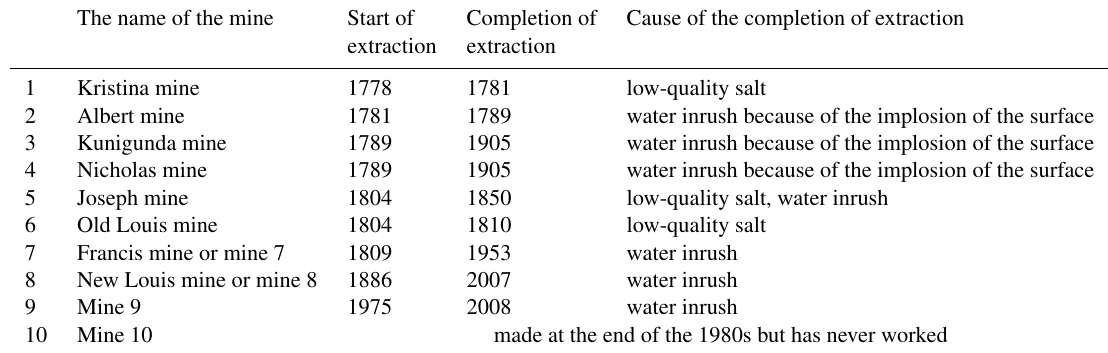
Figure 3. The investigated area. (a) Overview map of Solotvyno and its surroundings, showing the approximate location of the salt dome. Lakes with hatch pattern show sinkholes opened after the detailed geomorphological mapping of © Móga et al. (2015). (b) Topographic profile across the section (black line) marked in (a) . (c) Geological cross section of the Solotvyno salt dome. Legend: (1) fluvial sediments; (2) Tereblya Formation; (3) Solotvyno Formation; (4) Novoselytsa Formation. (d) Detailed picture of the area with the salt mines shown on a UAV map. (1) Kristina mine; (2) Albert mine; (3) Kunigunda mine; (4) Nicholas mine; (5) Joseph mine; (6) Old Louis mine; (7) Francis mine or mine 7; (8) New Louis mine or mine 8; (9) mine 9; (10) mine 10. Lakes are depicted in blueish shades. Table 1. Summary of mining activity in